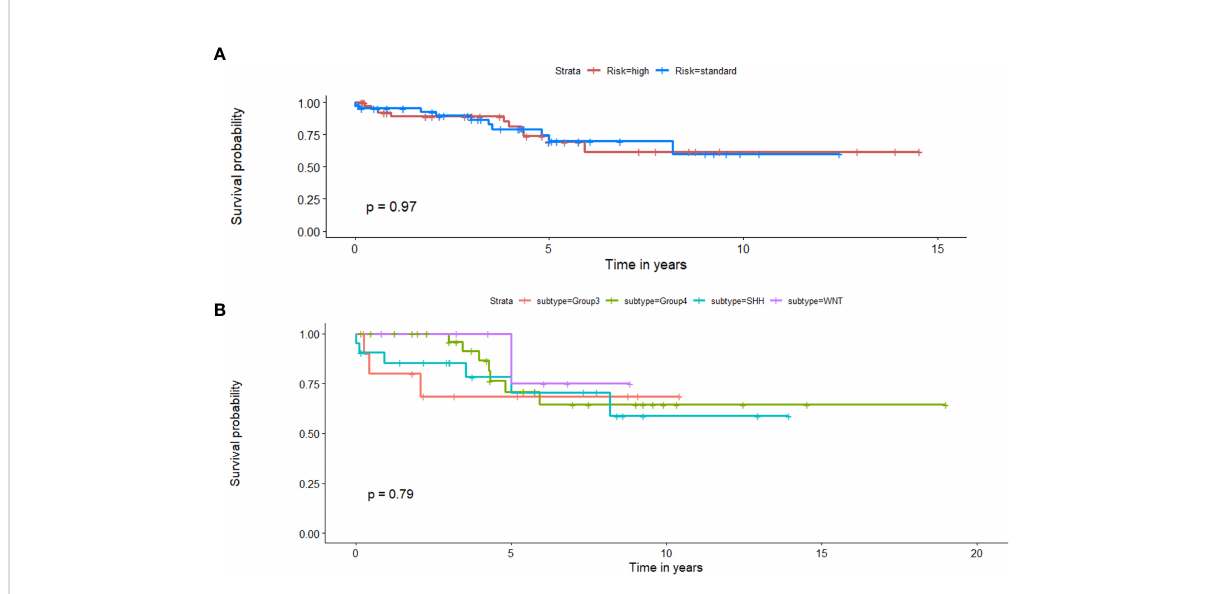
FIGURE 8 Kaplan Meier curves that illustrate survival analysis conducted using (A) Chang ’ s strati fi cation information, and (B) molecular subgroup information for the MB subjects from both datasets. X-axis represents overall survival in years, and Y-axis represents the estimated survival